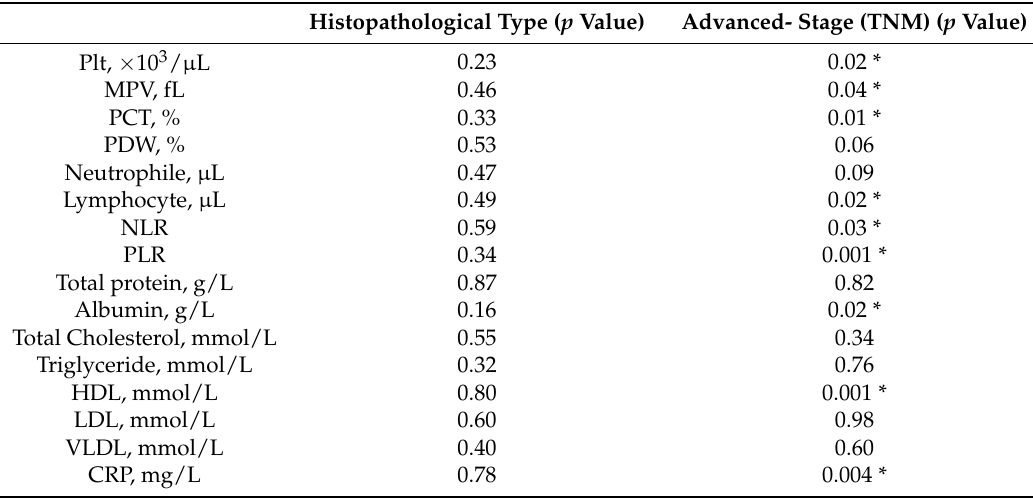
Table 2. The relationship between laboratory findings and histopathological type and advanced- stage (TNM) in lung cancer group.